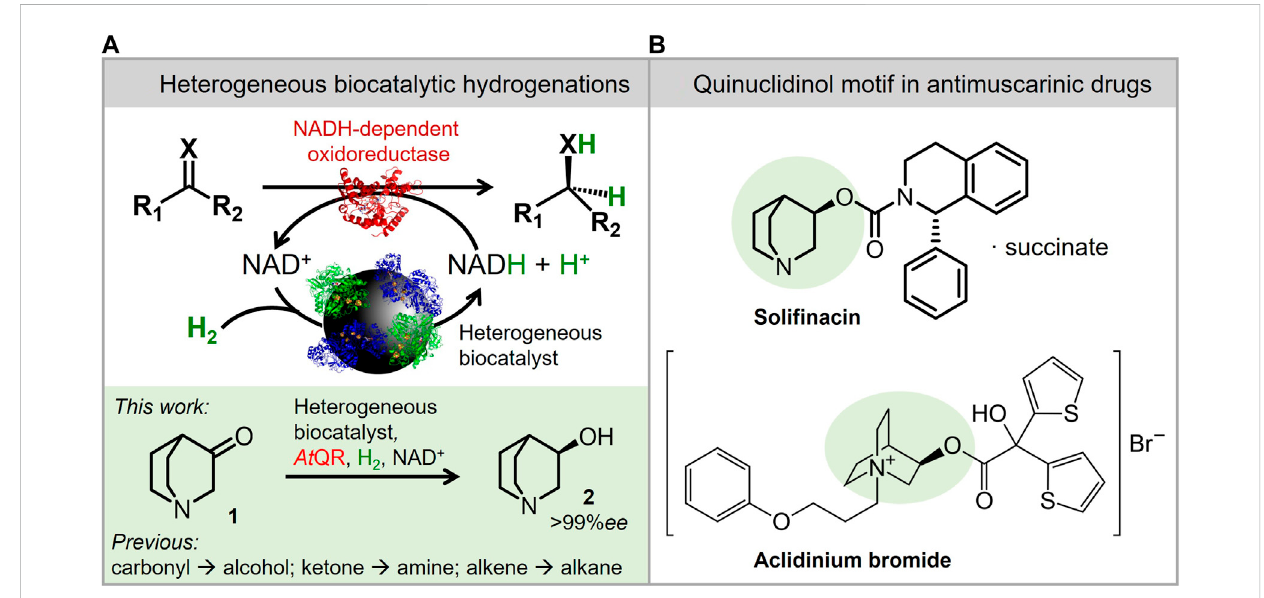
FIGURE 1 Heterogeneous biocatalytic hydrogenation as a strategy toward double-bond reductions. (A) Scheme to show the biocatalytic hydrogenation (see Supplementary Figure S1 in the ESI for mechanism details). This strategy was used here to reduce 3-quinuclidinone ( 1 ) to (3 R )-quinuclidinol ( 2 ). (B) (3 R )- Quinuclidinol ( 2 , highlighted in green) is an important motif found in approved antimuscarinic drugs Soli fi nacin and aclidinium bromide.